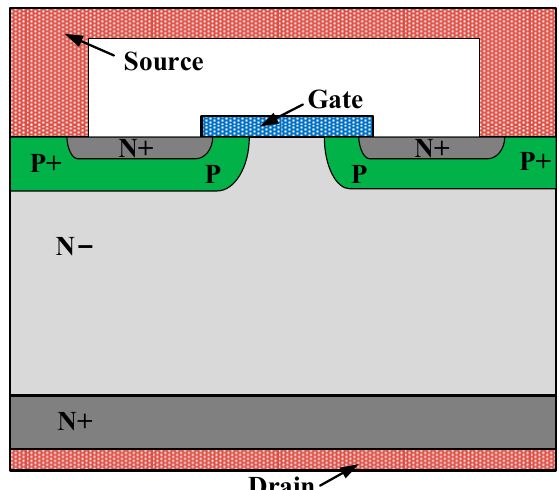
Figure 3. Structure of a power DMOSFET.